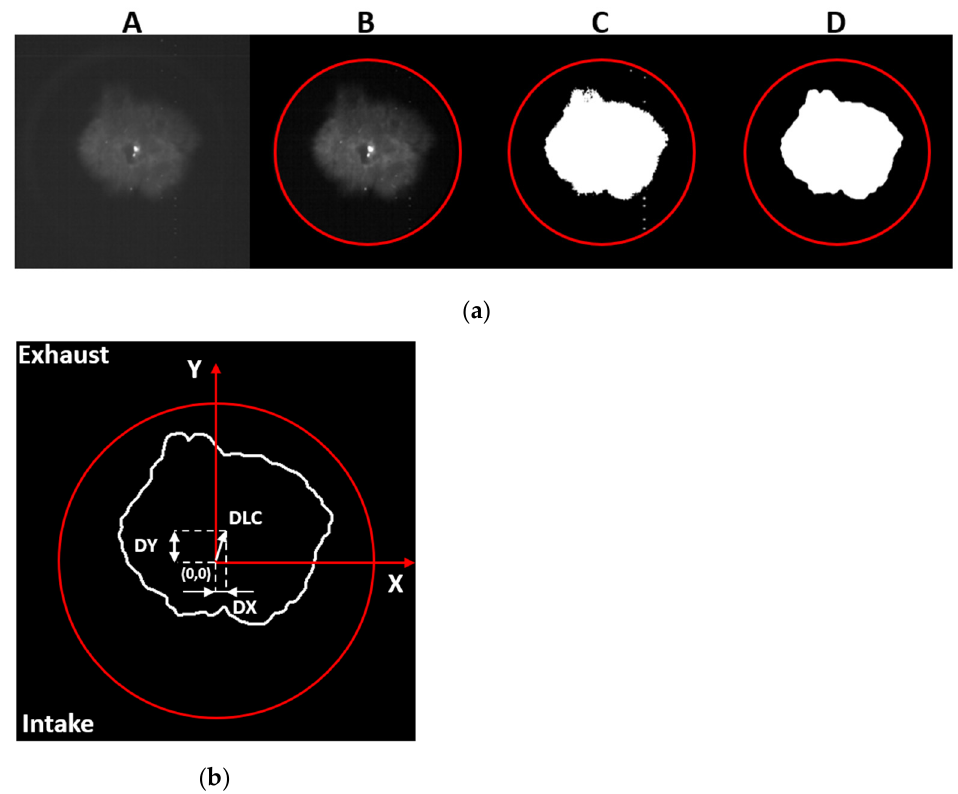
Figure 2. ( a ) Sequence of steps applied for image processing: ( A ) original raw data, ( B ) circular mask and gamma/brightness improvement, ( C ) image binarization, ( D ) FFT correction. ( b ) Flame area morphologic details.